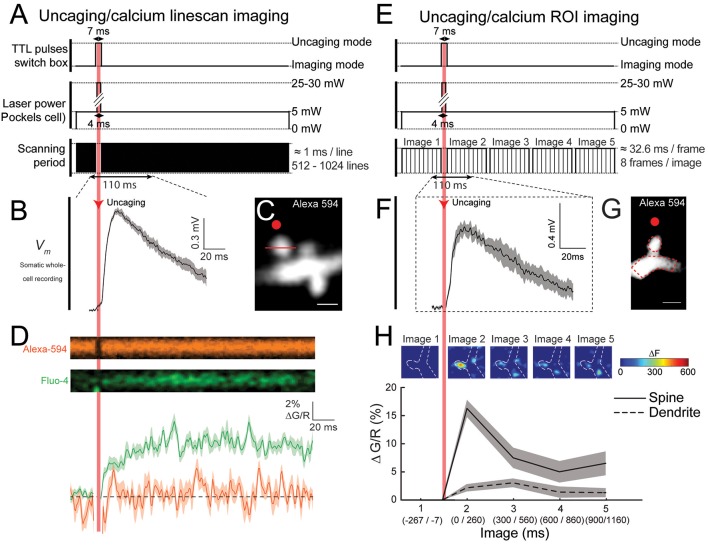
Near simultaneously imaging of calcium dynamics in the spines of layer 5 (L5) pyramidal neurons following glutamate uncaging. (A) Schematic representation of the TTL pulses being sent to the switchbox, the change in laser power over time and the imaging scanning period during a single trial, where each black line represents the beginning of a new linescan. Note the very brief interruption in the imaging during the uncaging. (B) Averaged uEPSP, recorded at the soma, evoked by 2P glutamate uncaging targeted 0.3 μm away from the head of the selected spine (20 trials). (C) 2P image of the selected spine of a L5 pyramidal neuron. Red dot: the uncaging spot; Red line: position of the linescan during calcium signal acquisition. (D) Top panel: linescan images illustrating the change in Alexa-594 and Fluo-4 fluorescence over time during a single trial. Bottom panel: quantification of the average change in the calcium and Alexa-594 signal (ΔGR) in the spine head following 2P glutamate uncaging for 10 trials. (E) Schematic representation of the TTL pulses being sent to the switchbox, the change in laser power over time and the scanning period during a single trial, where each thin black line represents the beginning of a new framescan and each black box represents a single averaged image being generated. (F) Averaged uEPSP, recorded at the soma, evoked by glutamate uncaging targeted 0.3 μm away from the head of the selected spine (20 trials). (G) 2P image of the selected spine of a L5 pyramidal neuron. The red dot represents the uncaging spot. (H) Top: color-coded images of the changes in fluorescence across the region of interest (ROI) during a single trial (ΔF). Quantification of the average change in the calcium signal (ΔGR) in the spine head and parent dendrites following glutamate uncaging at the spine head for 20 trials.